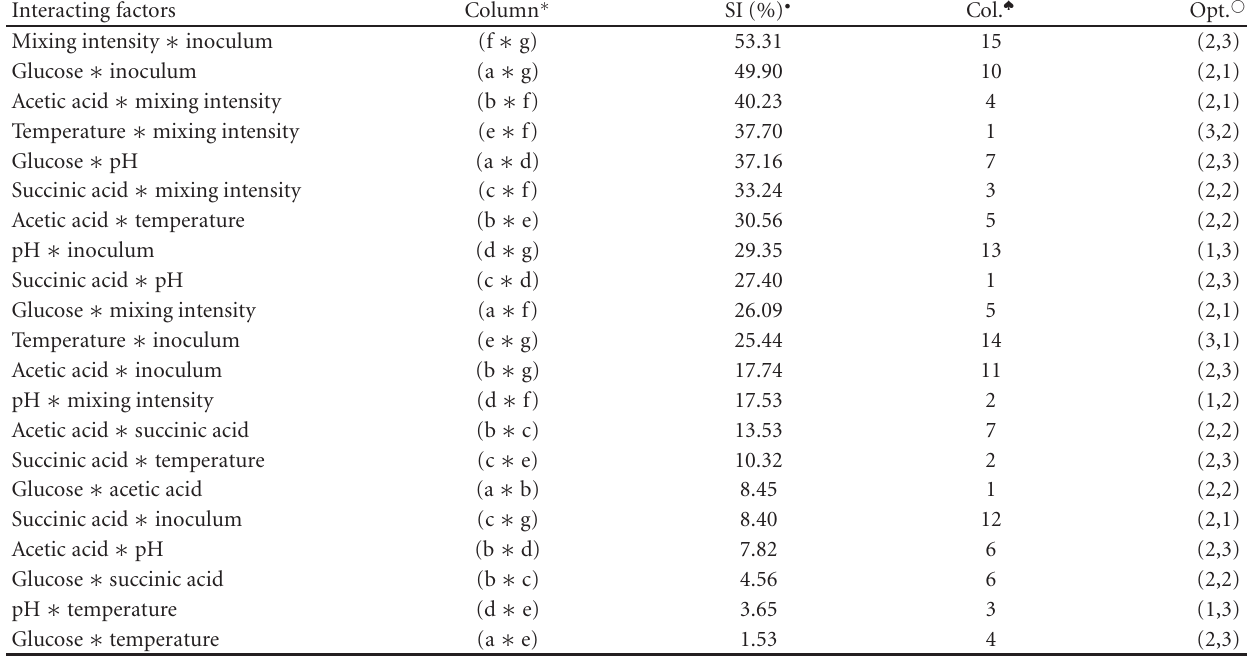
Table 4: The estimated interaction of severity index for di ff erent parameters.